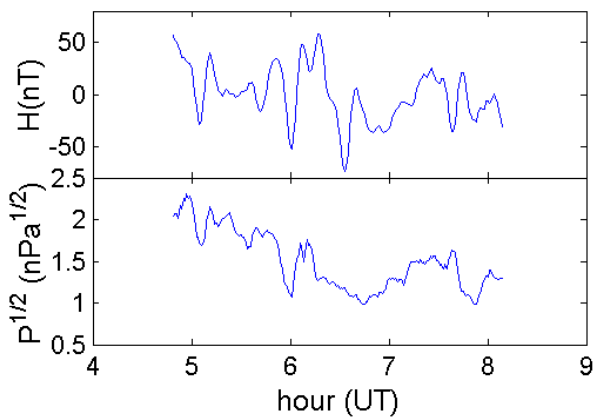
Fig. 9. The square root of the SW pressure and the H component at CHD in the time interval 04:50–08:10UT (SW data are shifted for the time delay of 37